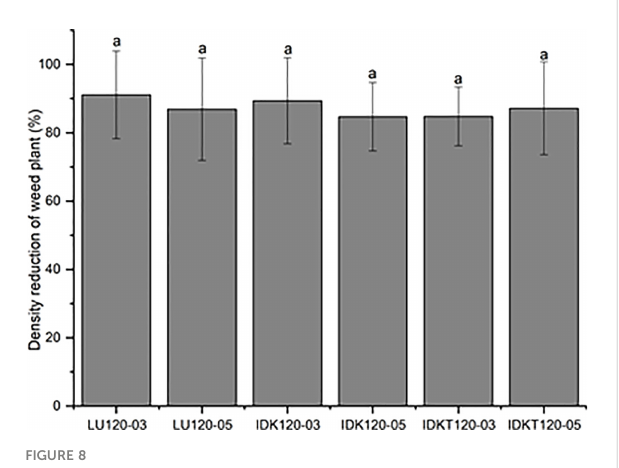
FIGURE 8 Biological ef fi cacy of herbicides applied in wheat fi eld using standard fl at fan nozzles and air-injector